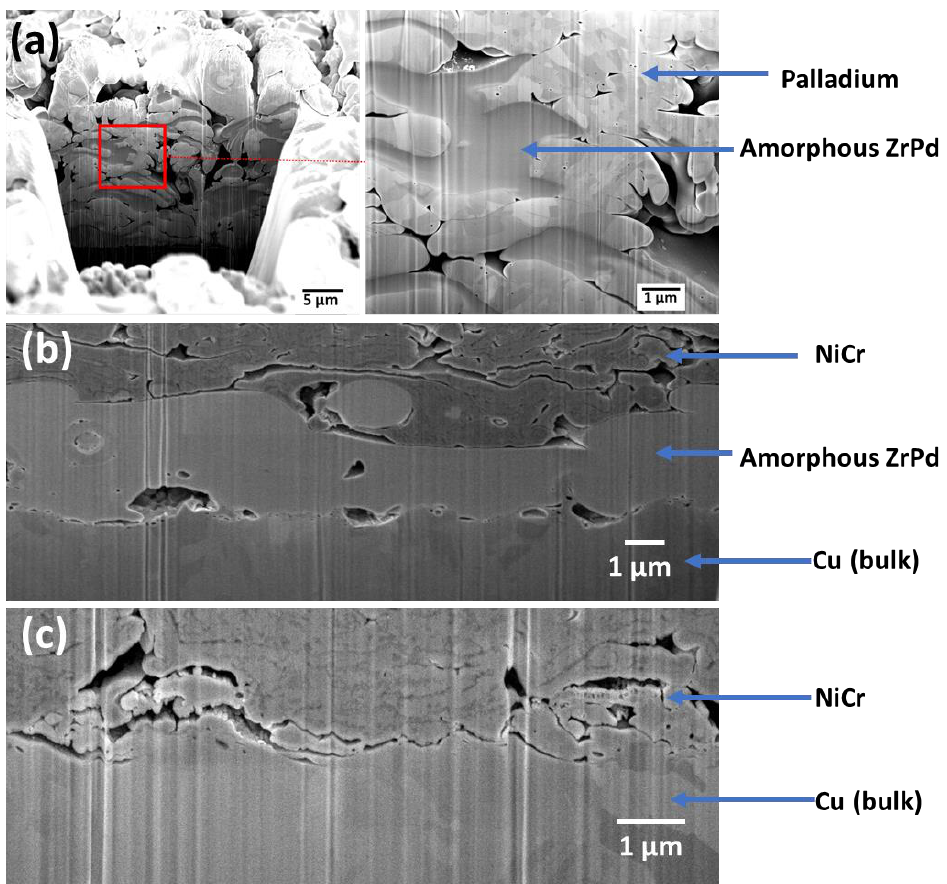
Figure 6. HR-SEM images of FIB cross-sections of LIFT printed multi-metal structures: ( a ) Mixed metal structures made of droplets of amorphous ZrPd along with crystalline Pd; ( b ) Amorphous ZrPd as an intermediate layer between LIFT printed NiCr and a bulk copper substrate; ( c ) NiCr directly printed on copper.